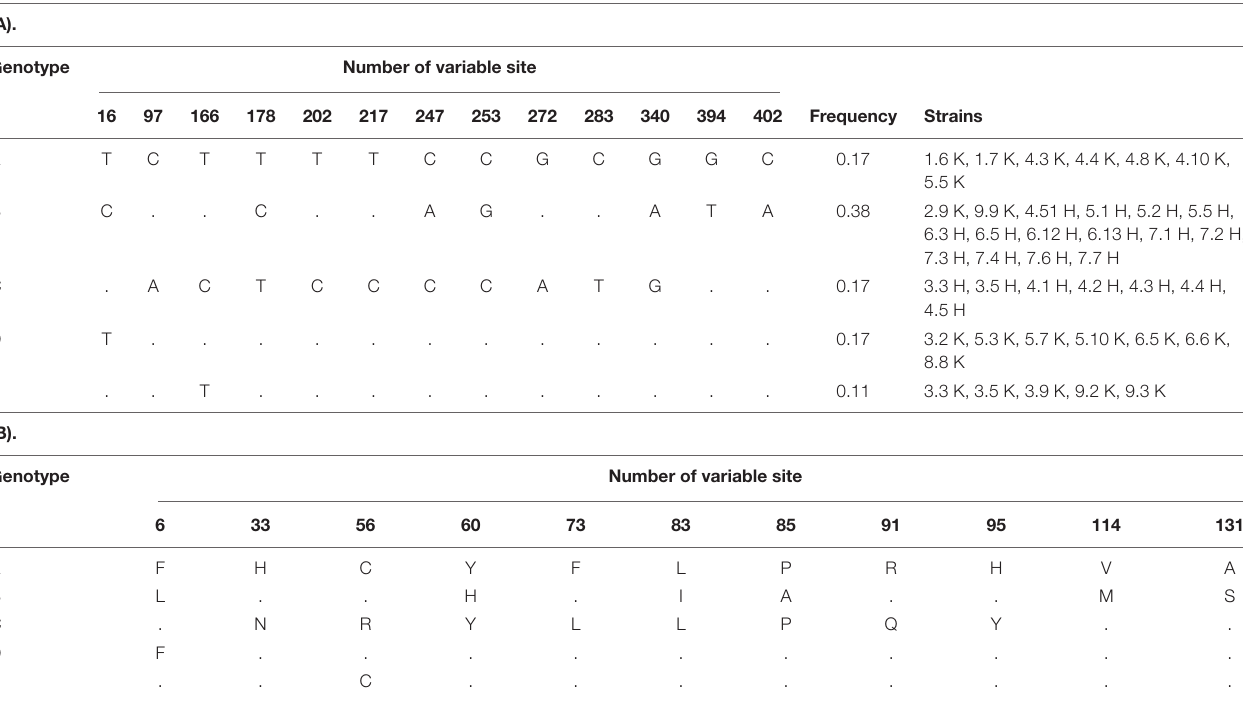
Values are represented as means ± SD (n = 20). Significant differences between groups were marked with different letters. TABLE 2 | Variable sites in 416-bp long fragments of the nodA gene (A) and corresponding amino acid sequences of NodA protein (B) of R. leguminosarum bv. trifolii strains from the metal-polluted waste heap and the reference area.